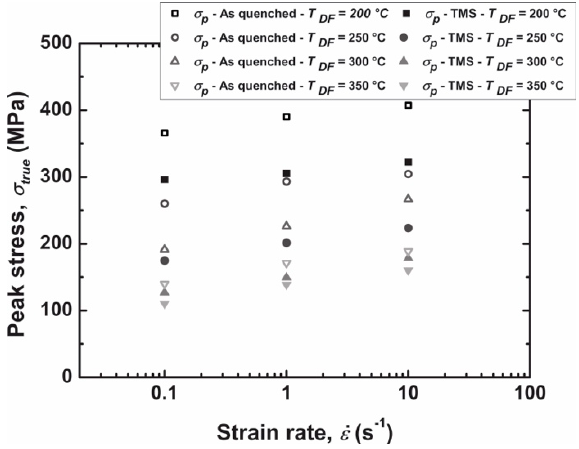
Figure 2. Measured peak stress 𝜎 (cid:3043) of as ‐ quenched and TSM conditions.